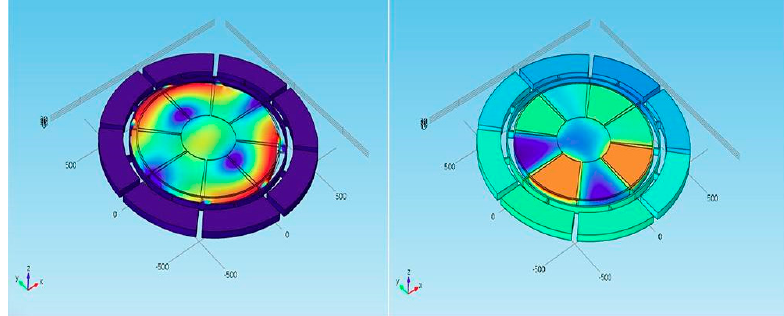
Figure 4. Piezoelectric gyroscope.